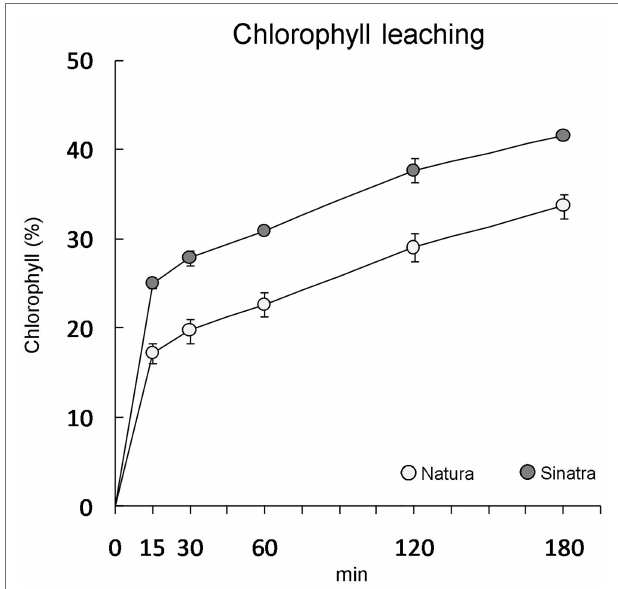
FIGURE 1 | Chlorophyll leaching of ‘Natura’ and ‘Sinatra’ fruit at harvest expressed as a percentage of total chlorophyll extracted after 24 h. Data presented are means ± SE of ten fruits. Differences between varieties were significant for every time assayed according to Duncan’s test ( p <